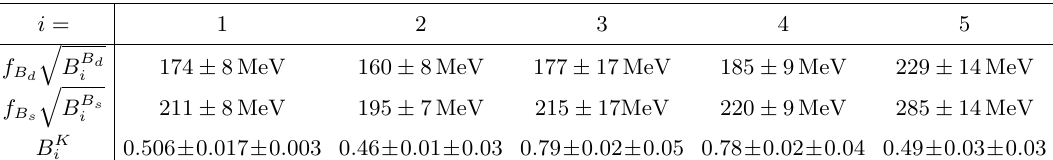
p B M ( M = B 0 ; B 0 ) [108] and B K s i d